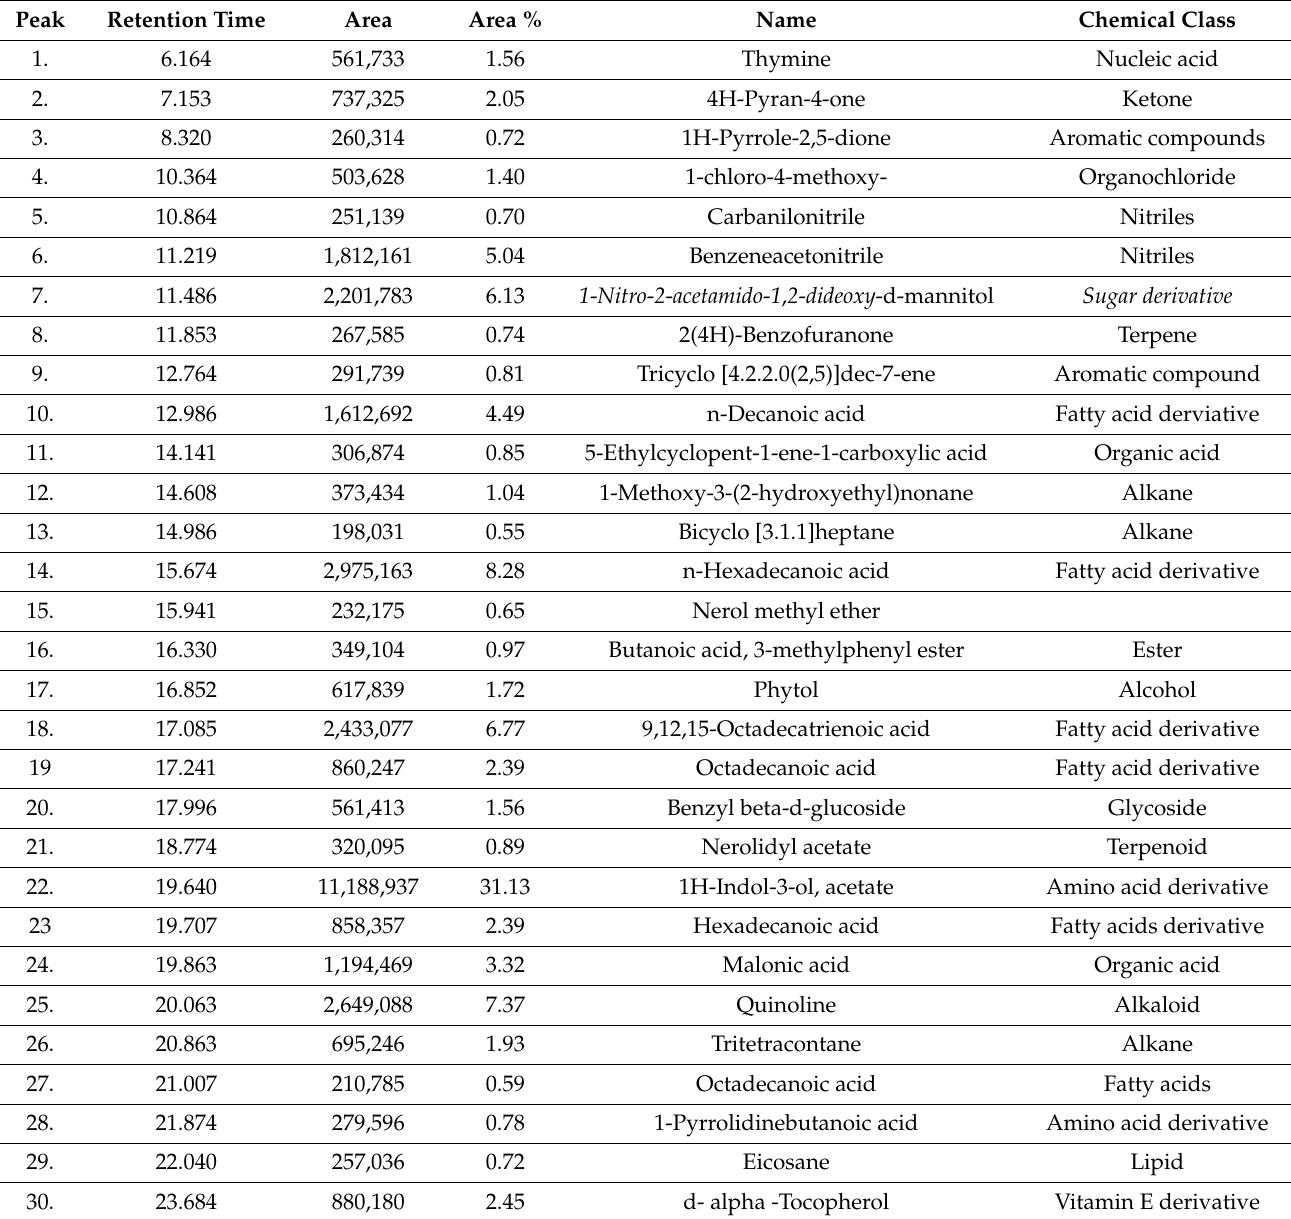
Table 1. List of constituents identified by GC-MS.